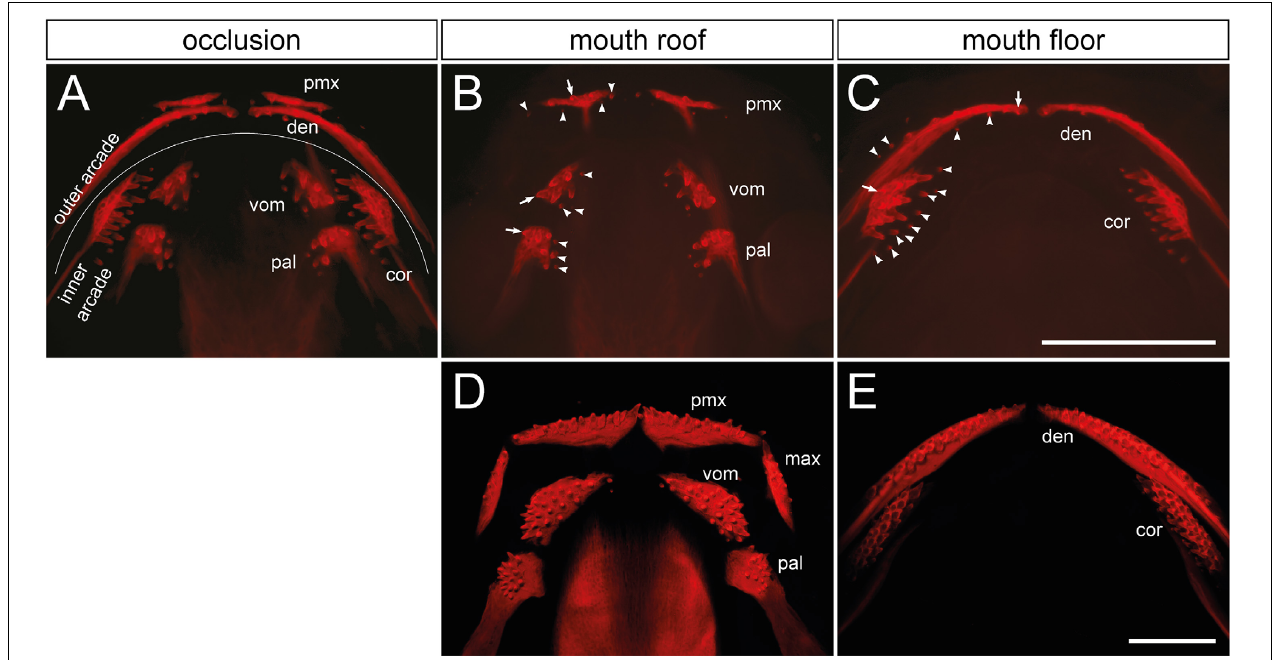
FIGURE 1 | Distribution and composition of axolotl tooth fields. (A) The dentition of an axolotl larva (19 mm TL) is composed of several tooth fields, which are assembled into outer (premaxillary and dentary) and inner dental arcades (vomerine, palatine, and coronoid). These arcades show various field-specific arrangements. Outer arcade fields form initially a single tooth row; inner arcade fields constitute tooth patches. (B,C) Separation of mouth roof from floor shows presence of the oldest tooth (arrow) and addition of new tooth germs (arrowheads) within each field. (B) In the premaxillary field (pmx), new germs are added laterally and medially as the field stretches along the upper jaw, and new germs are also added posteriorly. Vomerine (vom) and palatine (pal) fields develop by addition of new germs medially from the oldest teeth located laterally. (C) In the dentary field (den), the oldest tooth is present close to the mandibular symphysis and new germs are added laterally along the lower jaw, thus forming the tooth row. New germs are further initiated lingually. In the coronoid (cor) field, the oldest tooth is located labially and new germs are added lingually in a hand fan-shaped manner. (D,E) The dentition of a 41 mm TL axolotl larva shows a single-rowed arrangement of premaxillary (pmx), maxillary (max), and dentary (den) fields, and a multi-rowed arrangement of vomerine (vom), palatine (pal), and coronoid (cor) fields. Scale bars equal 1 mm.